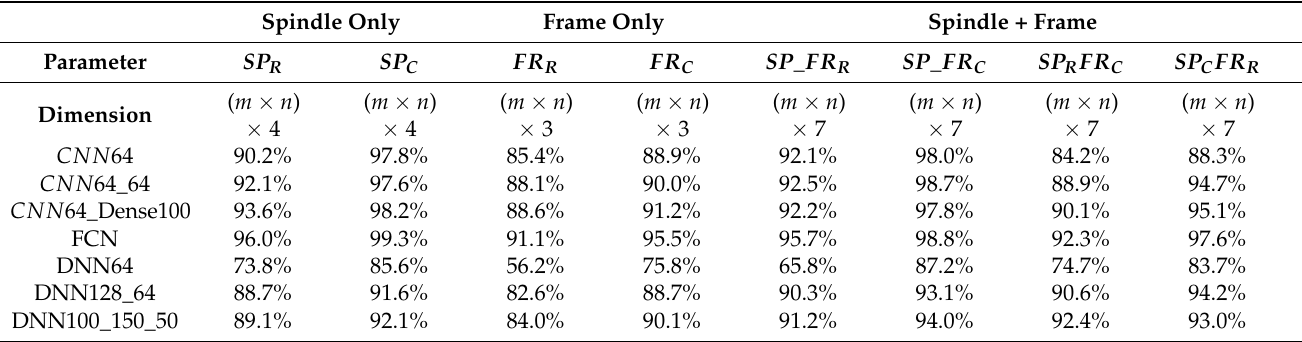
Table 2. Test accuracy of DL models on different input/source data